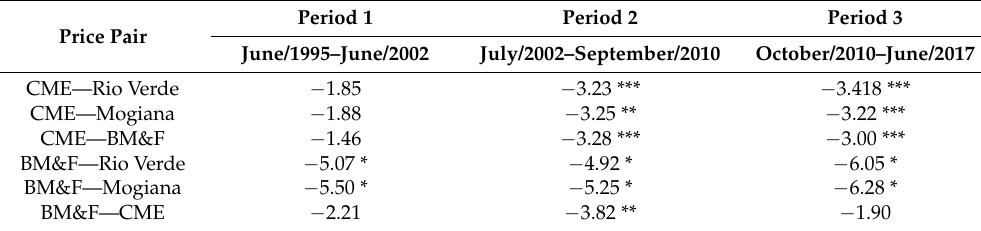
Table A2. Engle–Granger tests for co-integration between corn price pairs (CRADF).